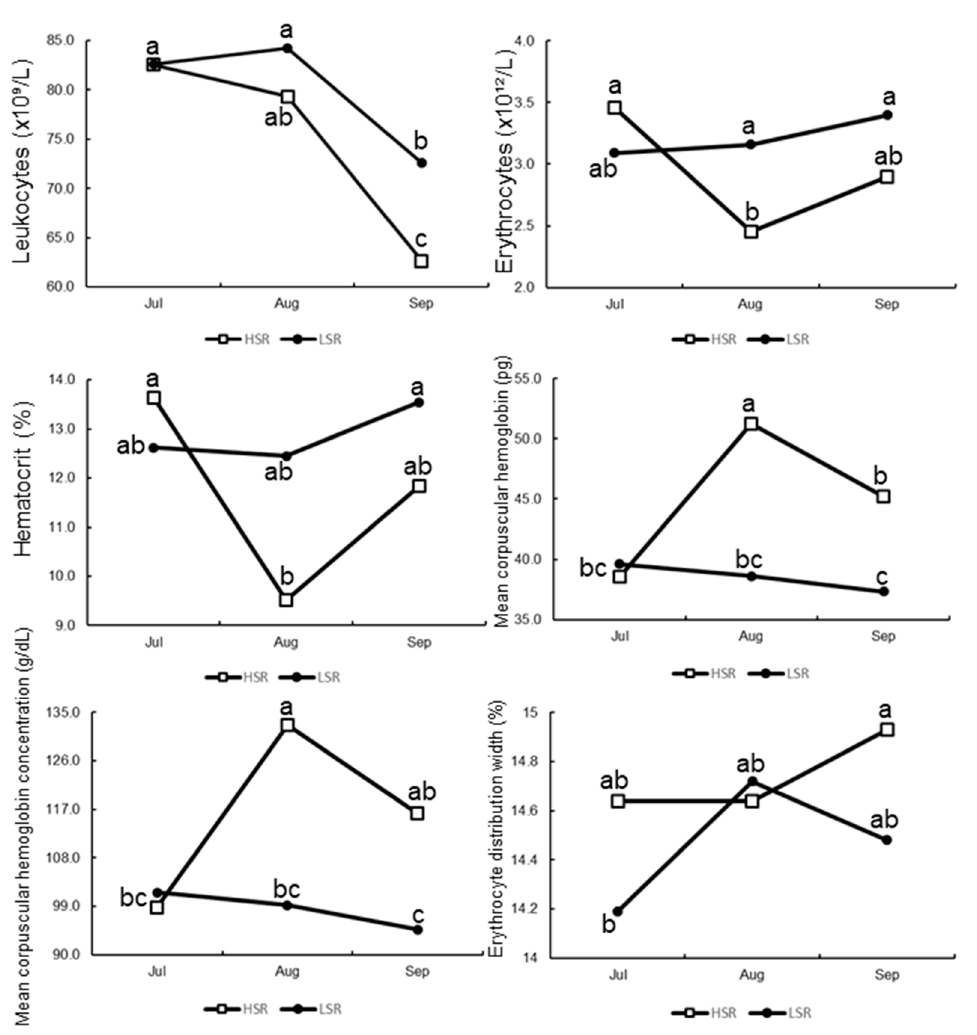
Figure 4. Least square means for leucocytes ( × 10 9 /L), erythrocytes ( × 10 12 /L), hematocrit (%), mean corpuscular hemoglobin (pg), mean corpuscular hemoglobin concentration (mg/dL), and erythrocyte distribution width (%), according to either low or high social rank (i.e., LSR and HSR) in Dorper rams ( n = 24) in northern Mexico (25° N). a,b,c Least squares means lacking a mutual superscript within response variable differ ( p < 0.05).